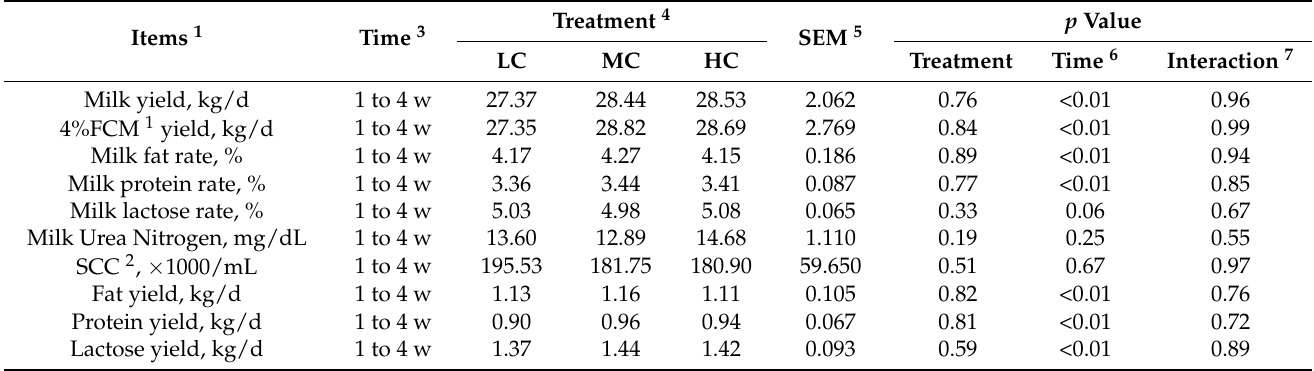
Table 4. Effects of different prenatal concentrate levels on milk production and milk composition of dairy